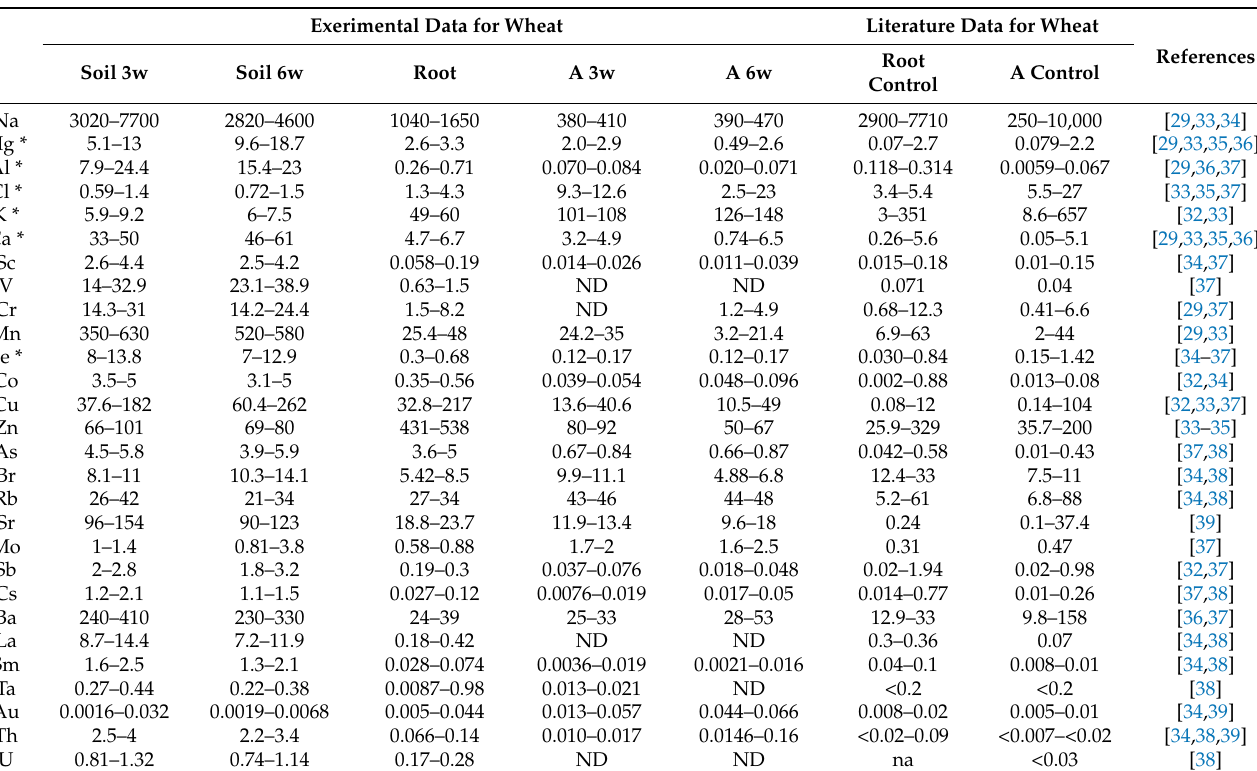
Table 1. Element content (minimum and maximum values) in soil and wheat after three and six weeks of exposure